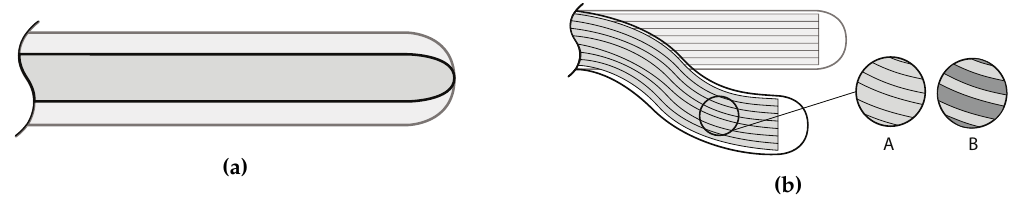
Figure 1. ( a ) Cross-section shaping: the cross-section is modified, which causes a change in the second moment of area I ; ( b ) structural interactions change: the layers composing the beam may be disconnected or locked with each other, modifying the second moment of area I ; ( A ) multi-layer beam made of a single material; ( B ) multi-layer beam made of multiple